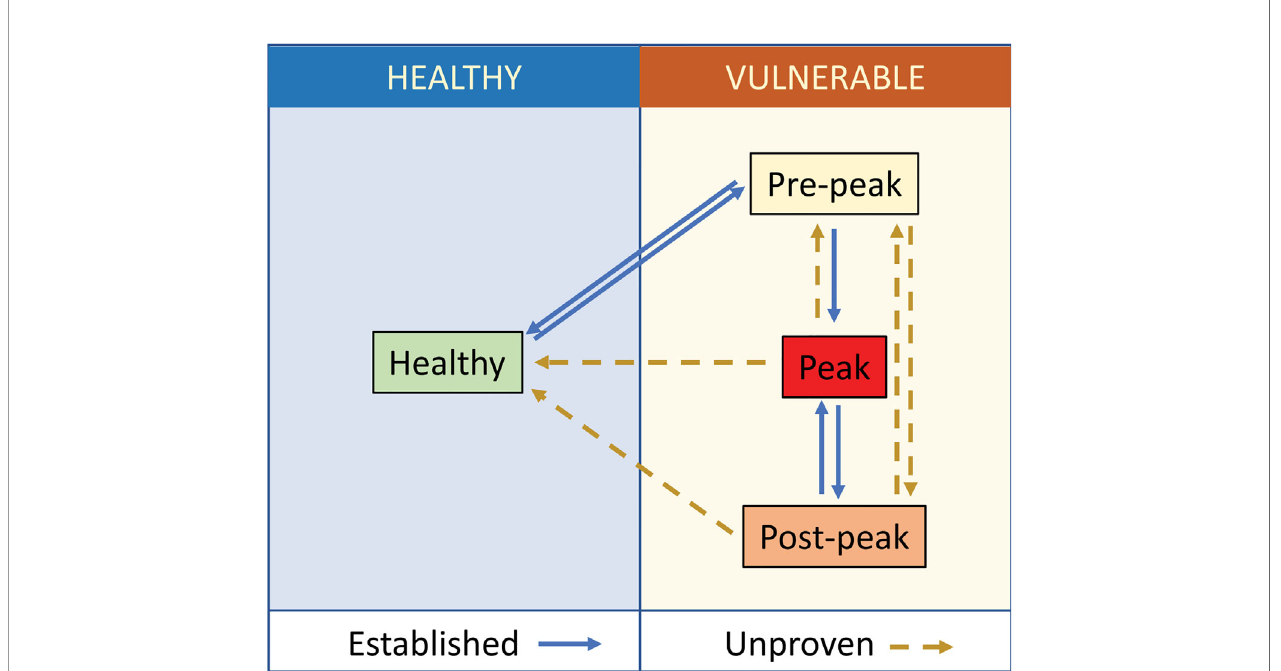
FIGURE 1 | Tissue states in ocular in fl ammation. Healthy ocular tissue is ‘ immune-privileged ’ and under low-level immunosurveillance. Speci fi c (ocular antigen driven) and non-speci fi c (extra-ocular in fl ammation) stimuli disturb this homeostasis and increase interactions across the blood retinal barrier making the tissue more vulnerable to the development of disease. In uveitis following active immunization, this starts with the prodrome (8), which can resolve back to the healthy state. When the prodrome progresses to clinical EAU in immunocompetent animals, there is an in fl ux of cells to a maximum (peak) followed by a reduction in immune cell content, which does not return to base line. The post-peak (in EAU described as secondary regulation) is distinguished from the pre-peak by changes in the relative proportion of different lymphocyte populations (CD4 T regulatory cells, CD8 T resident memory cells). There is currently no evidence that disease proceeds directly from pre-peak to post-peak, nor that eyes that have reached peak disease ever return to the normal healthy